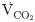
Effects of H5N1 viral infection on animal body temperature (BT), body weight (BW), and metabolism (V˙CO2).In each mouse of the three groups (n = 6, 15, and 7 for Ctrl, HK483 and HK486 mice), the same measures (BT, BW, V˙CO2) were repeated at 2 and 1 days before and 1, 2, and 3 days after intranasal inoculation (Day -2, -1, 1, 2, and 3). Mean ± SE. As the results show, there is no significant difference of BT, BW and V˙CO2 among the three groups.